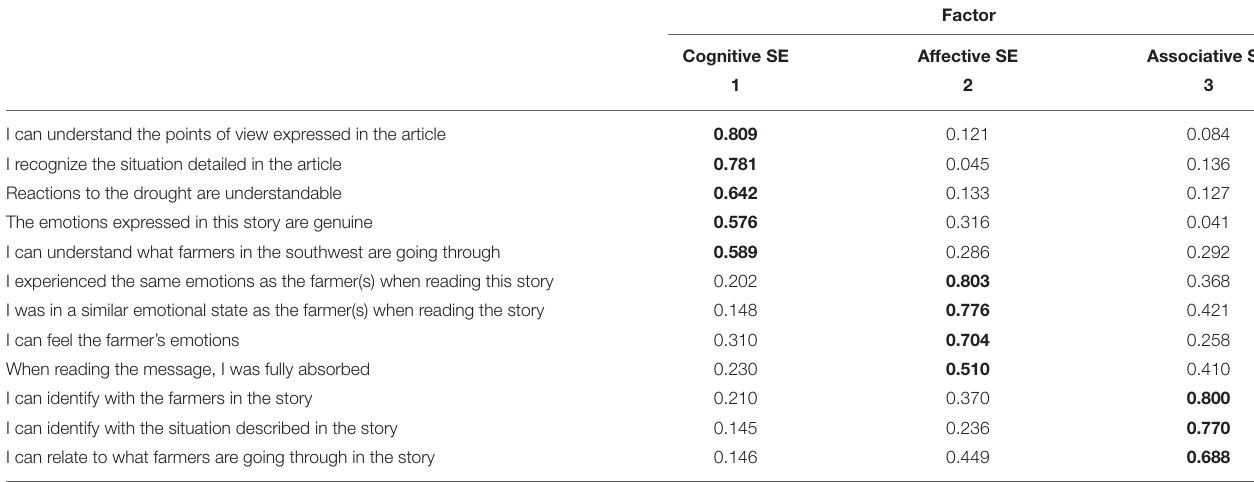
TABLE 1 | Factor solution for state